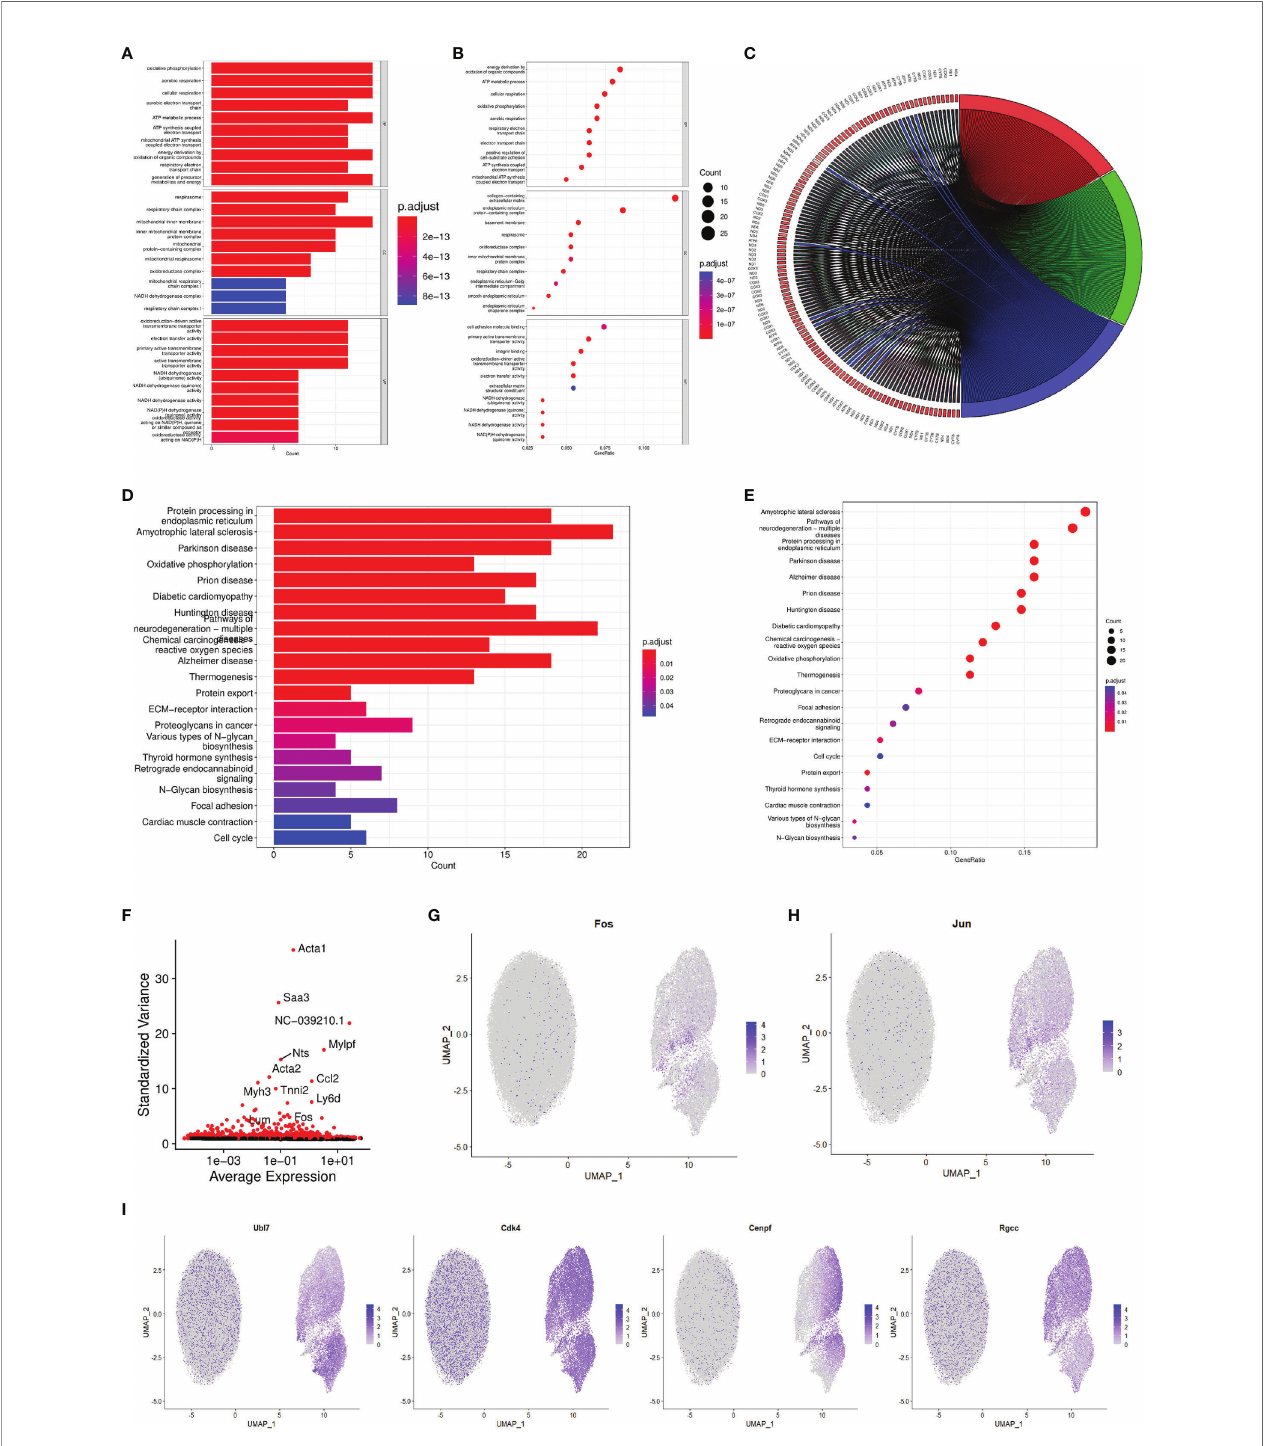
FIGURE 3 | Characterization of the functional enrichment response during FMDV-persistent infection. Bar (A) and dot (B) diagram of the GO enrichment of BHK- Op. The dot from small to big corresponds to a small to large amounts of gene expression, and the color from blue to red corresponds to a low to high abundance of gene expression. Chord diagram (C) showed the relationship between genes and individual GO items. Bar (D) and dot (E) diagram of the KEGG enrichment of BHK-Op. The dot from small to big corresponds to a small to large amounts of gene expression, and the color from blue to red corresponds to a low to high abundance of gene expression. Scatterplot of gene dispersion (F) labeled the top fi fteen genes with the greatest amount of variation. In two dimensions, the expression levels of FOS (G) , JUN (H) , and four other randomly selected genes (I) were displayed. The color light to dark corresponds to a low to high abundance of gene